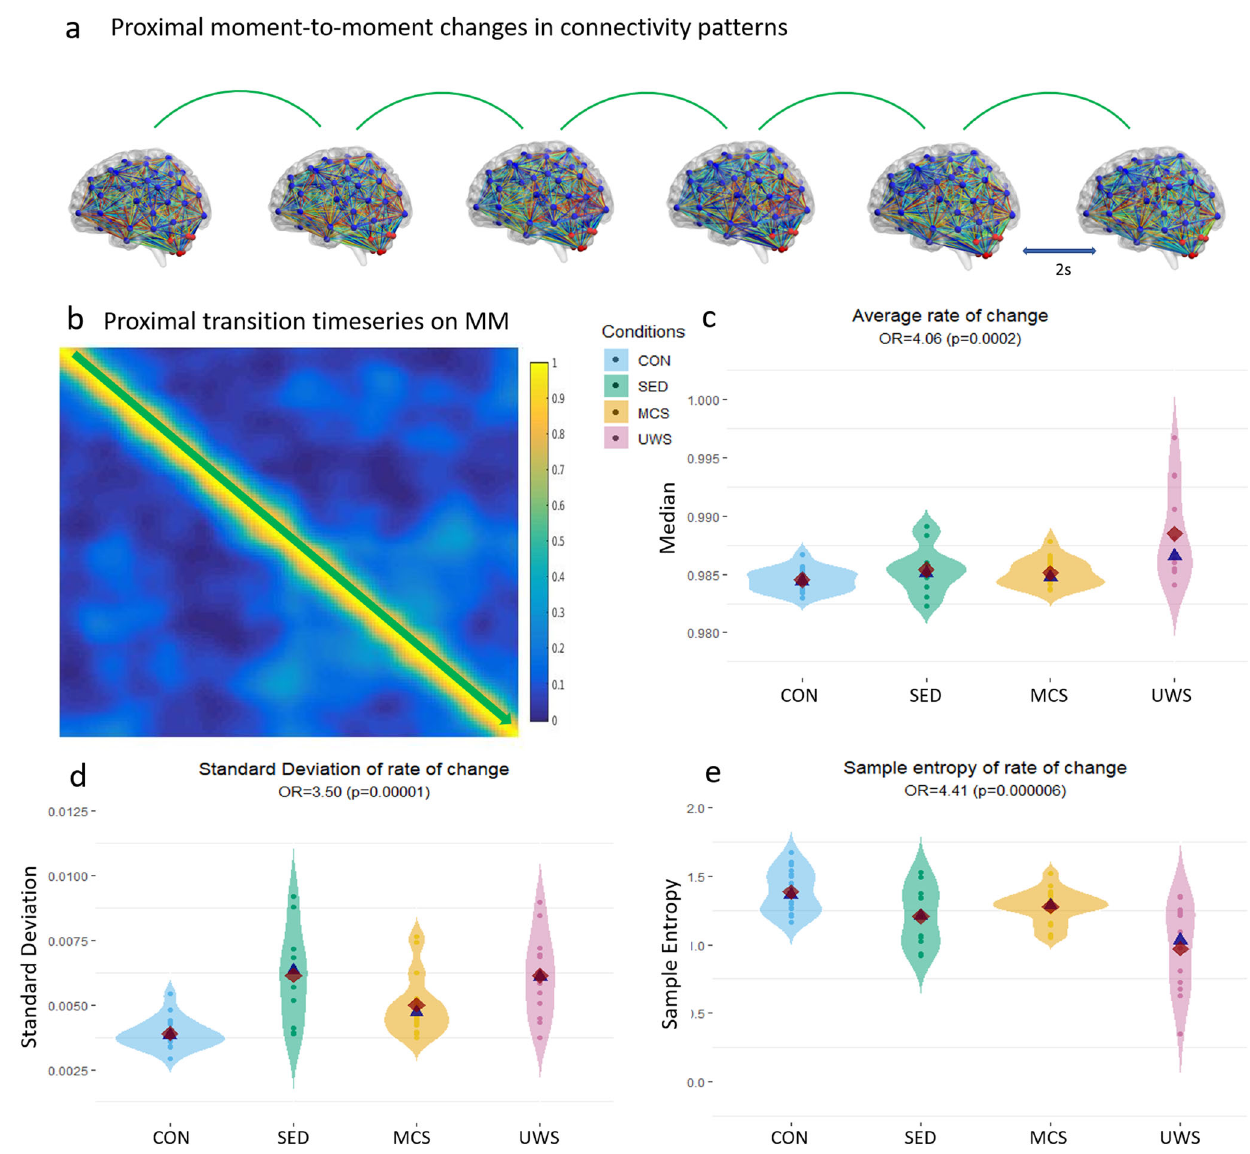
Fig. 2 Proximal network transitions; description and analyses. a Depicts the short-term transitions between each successive connectivity pattern (time = 2s). The distance between these was measured via Pearson ’ s correlation (see Supplementary Note 2 for alternative distance metrics used). b Shows where in the meta-matrix this information is represented (along the diagonal); shown by a green arrow. On the resulting timeseries, describing the rate of change of connectivity patterns over time, we calculated the average c , the standard deviation d and the sample entropy ( e ; see Supplementary Note 4 for alternative methods). These measures were inserted as an independent variable in ordinal logistic regression with conditions ordered according to presumed levels of awareness (control awake > sedation > minimally conscious state > unresponsive wakefulness syndrome). CON = control awake n = 18, SED = sedation n = 18; MCS = minimally conscious state n = 11; UWS = unresponsive wakefulness syndrome n = 12. OR = odds ratio. Red rhombi represent the mean, whilst blue triangles, the a 24-point cut-off (48s) as this ensured sliding windows were not overlapping. We then created another symmetrical matrix from the off-diagonal triangle by mirroring it across the new diagonal (Fig. 3b, c) and obtained the distal meta-matrix (dMM; Fig. 3c). Each column of this new matrix represents a connectivity pattern and the cells represent the similarity to other connectivity patterns that are distant in time. The dMM (Fig. 3c) therefore approximates the position of a speci fi c connectivity state in a wider space of possible states, via the relationship (i.e., distance) to all other states. Whilst the proximal space dynamics are more easily understood (as time progresses, similarity tends to decay; or distance tends to increase [see TSDM Fig. 1e]), the dMM may approximate a more complex and higher dimensional state space